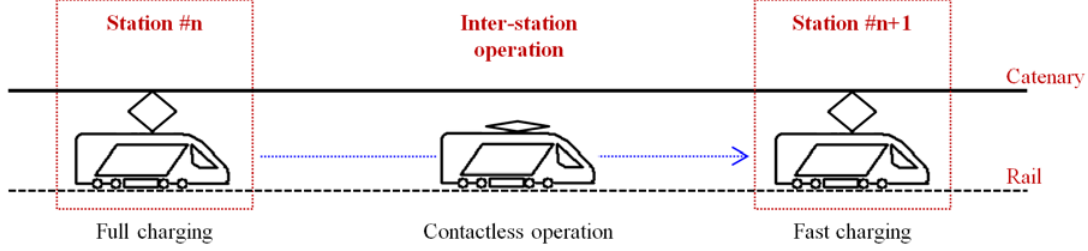
Figure 3. Operation scheme of wireless railway train (WRT).